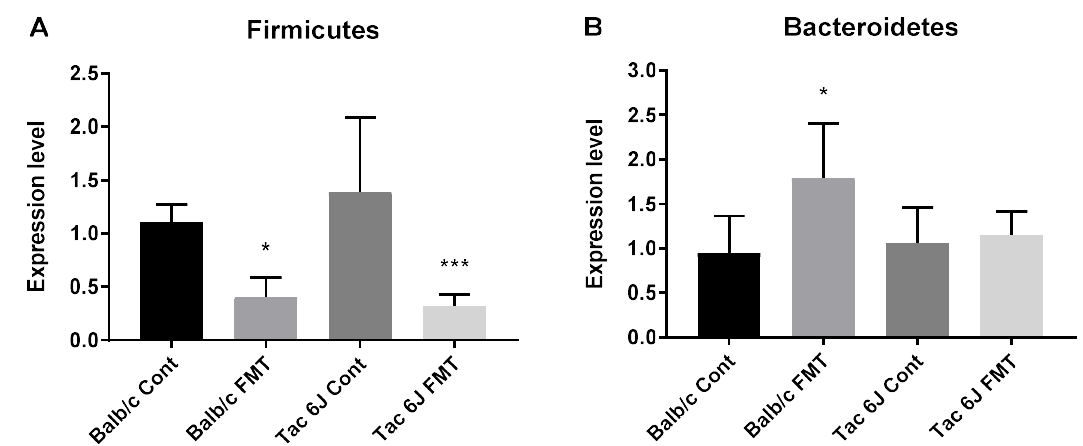
Figure 10. Fecal microbiota composition after FMT. Fecal microbiota composition was measured after two weeks of FMT. The Balb/c Anti group received fecal samples of Tac Cont group and was labelled Balb/c FMT. The Tac 6J Anti group received fecal samples of the Balb/c Cont group and was named Tac 6J FMT. FMT samples were orally gavaged for two weeks. Each group comprised 4–7 animals. ( A ) Expression levels of Firmicutes of the Ori 6N and Tac 6N groups; ( B ) Expression levels of Bacteroidetes of the Ori 6N and Tac 6N groups. The data represent the means ± SD and were analyzed by Fisher’s LSD test compared to the corresponding control group. Significance is indicated when * p < 0.05, and *** p < 0.001.